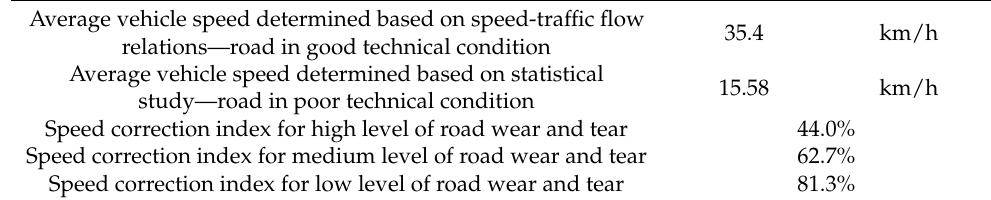
Table 1. Truck speed correction indices depending on technical road wear and tear.